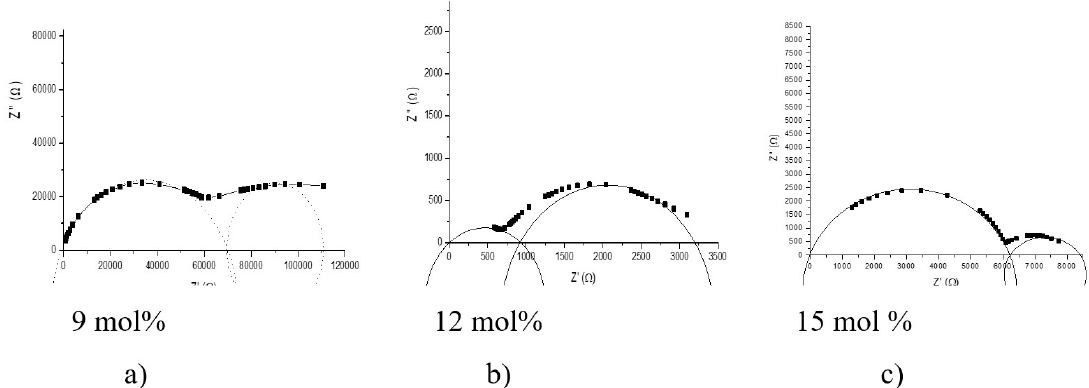
Figure 11. Complex impedance plots at 500 o C for three samples with CaO a) 9 Mol % b) 12 mol % c) 15 mol%.